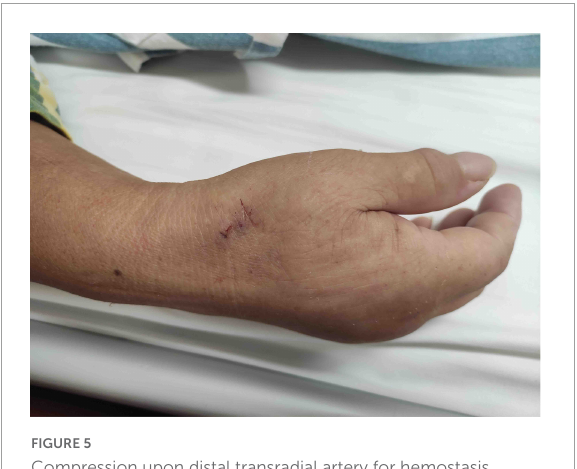
FIGURE5 Compression upon distal transradial artery for hemostasis.